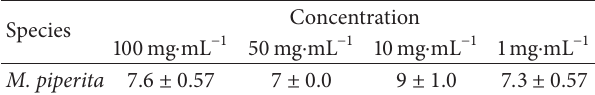
Table 5: Measurement results of the inhibition halos (mm) of the M. piperita essential oil against Escherichia coli strains